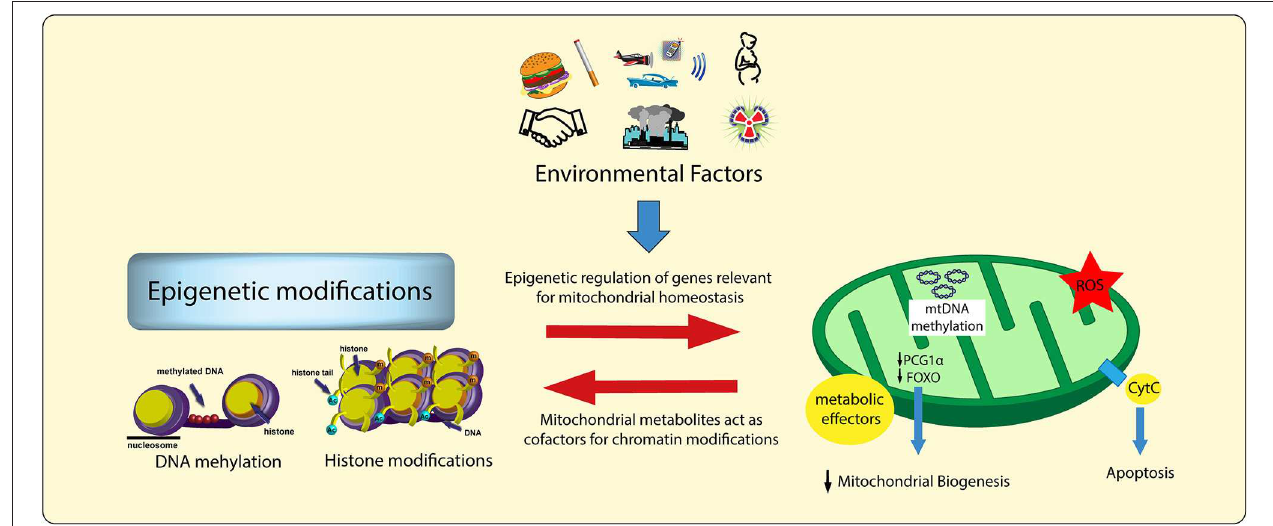
FIGURE 2 | Environmental factors, chromatin modifications, and mitochondrial damage. Environmental factors lead to specific epigenetic signatures as well as to alterations of mitochondrial intermediate metabolites (i.e., acetyl-CoA, FAD + , NAD + ). These two processes influence each other, thus leading to a vicious cycle responsible for adverse chromatin modifications, maladaptive transcriptional programs, and vascular dysfunction. ROS, reactive oxygen